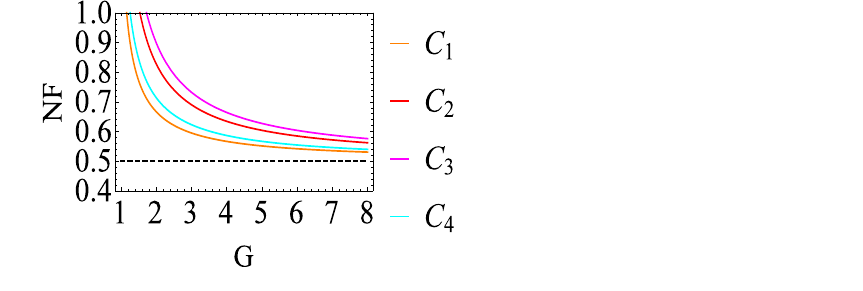
Figure 5. The dependence of Equation (9) on G for the case of λ = 1 and Φ = 0. The black dashed line is